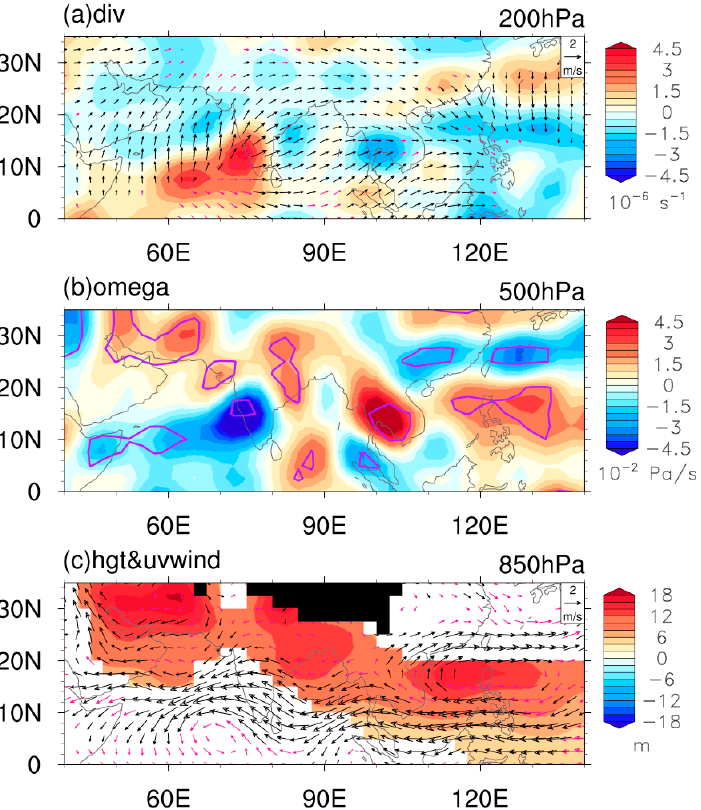
Figure 8. Difference in atmospheric circulation between Pos_year and Neg_year. Shading indicates the difference in: ( a ) divergence at 200 hPa; ( b ) vertical motion at 500 hPa; and ( c ) geopotential height at 850 hPa. In ( a , c ), vectors show the difference in divergent wind at the corresponding levels; black vectors indicate better than the 0.05 significance level. In ( b ), purple contours indicate the p -value at a significance level of 0.05. In ( c ), only the difference in geopotential height exceeding the 0.05 significance level is presented. Values below the ground surface are shaded black.